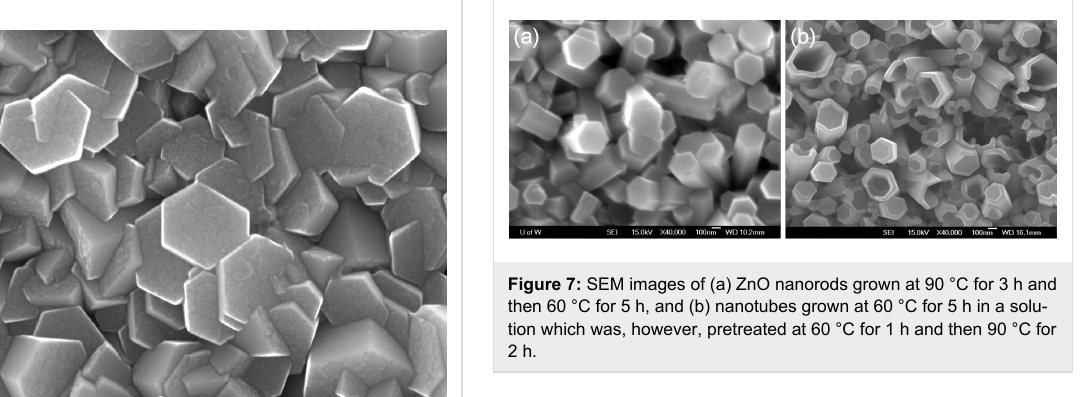
temperature and the growth time with the exception of the initial growing conditions, i.e., supersaturated or not, and the pH value of solution. Compared with the nanorods in Figure 6, the ZnO nanotubes in Figure 3b have smaller diameters and larger aspect ratios due to the somewhat lower pH value of the reaction solution. This, in turn, indicates a high pH value may result in a low surface energy difference between polar and non- polar faces and thus inhibit the growth of ZnO along the [001] direction.